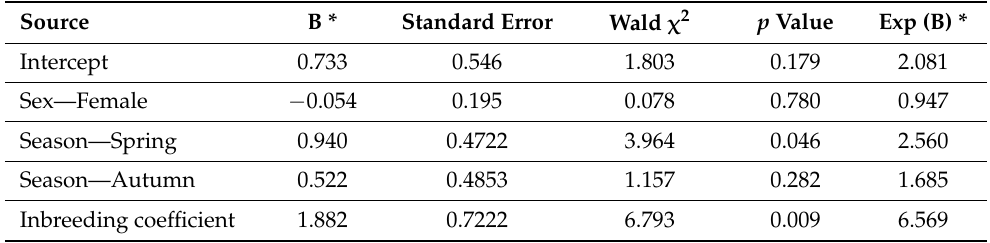
Table 5. The relationship between the sex, birth season and inbreeding level, and survival to the age of one month, of European bison belonging to LB line born between 1946 and 2021 with known pedigree. Males within sex and Winter within season were reference levels, with B value equal to zero. Source B